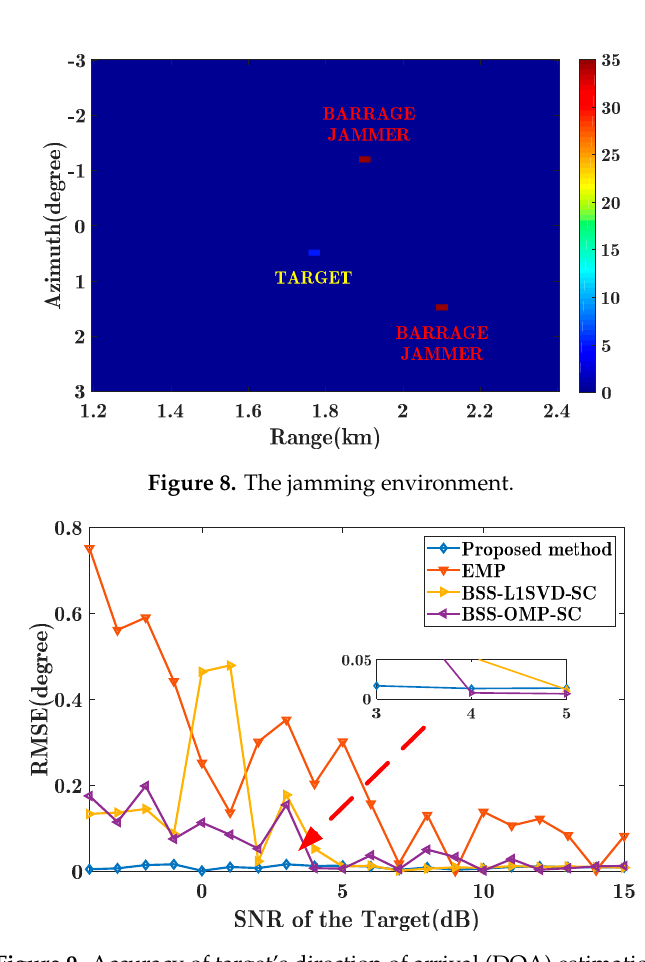
Figure 9. Accuracy of target’s direction of arrival (DOA) estimation.